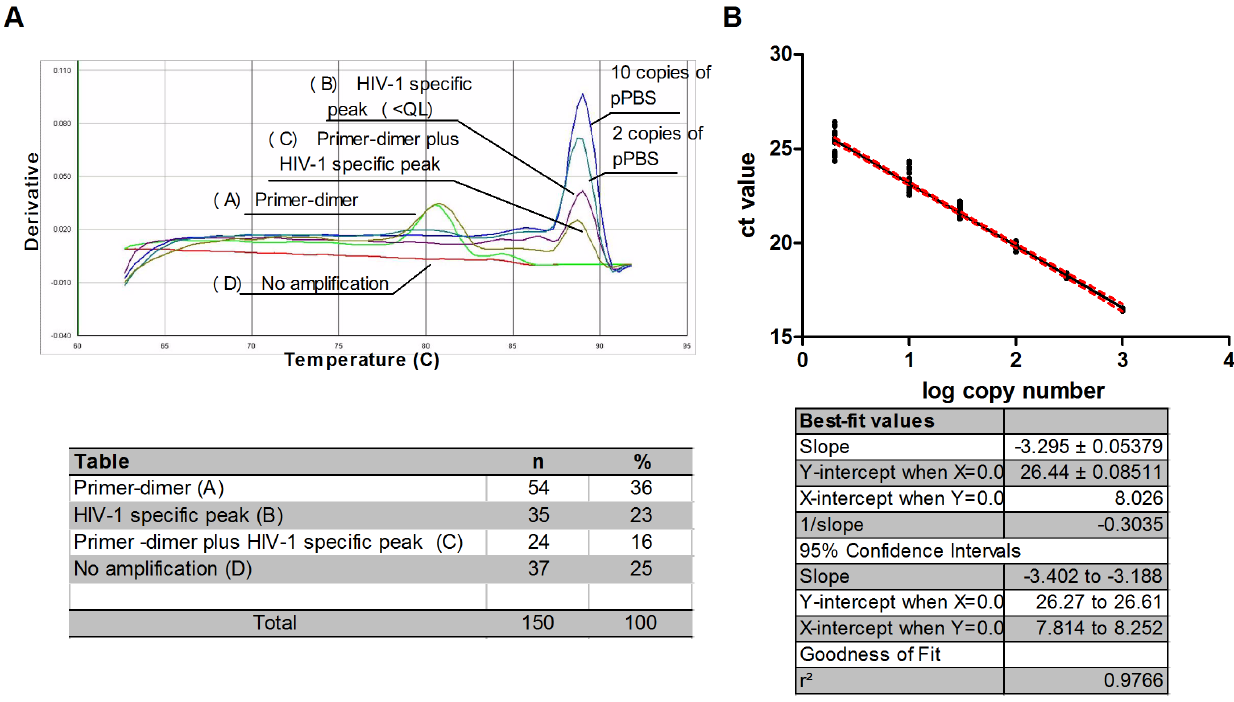
Figure 2. Post-PCR melt curve analysis and standard curve. (A) Different dissociation curves that are shown in percentages of their relative amounts in the analysis of 150 HIV-1 negative DNA samples. Only 10 and 2 copies of standard are displayed. (B) Mean standard curve obtained in the TotUFsys PCR experiments (n=8). doi:10.1371/journal.pone.0111919.g002 PLOS ONE |